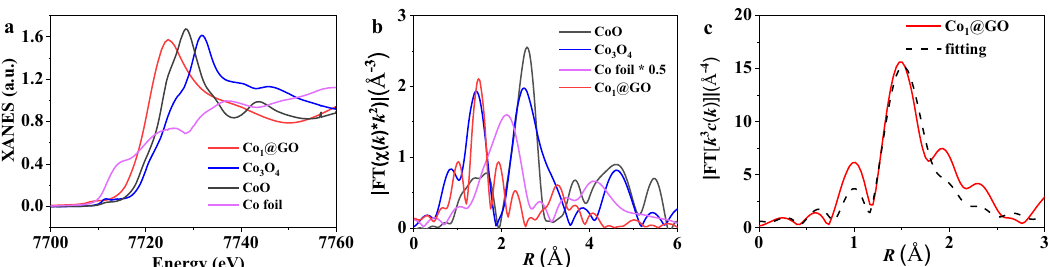
Fig. 3 X-ray absorption results of Co 1 @GO. a XANES spectra and b Fourier transforms (FTs) of the Co K-edge of Co 1 @GO, Co foil, CoO and Co 3 O 4 . c Corresponding fi tting of the EXAFS spectra of Co 1 @GO in R